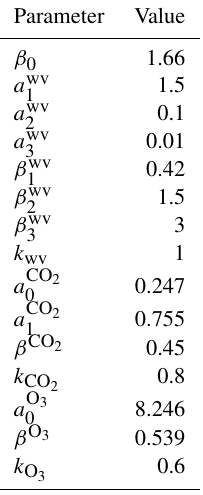
Table A7. Longwave radiation parameters.